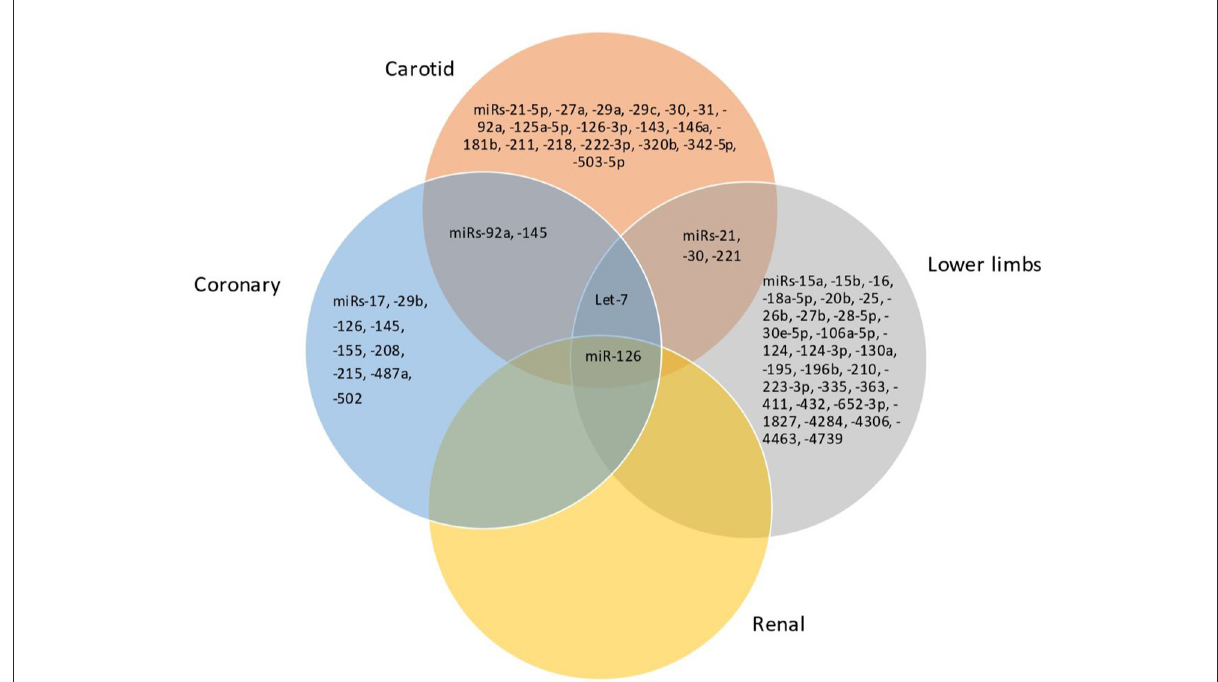
FIGURE2 Venn diagram showing the miRNAs shared between carotid, coronary, lower limbs, and renal